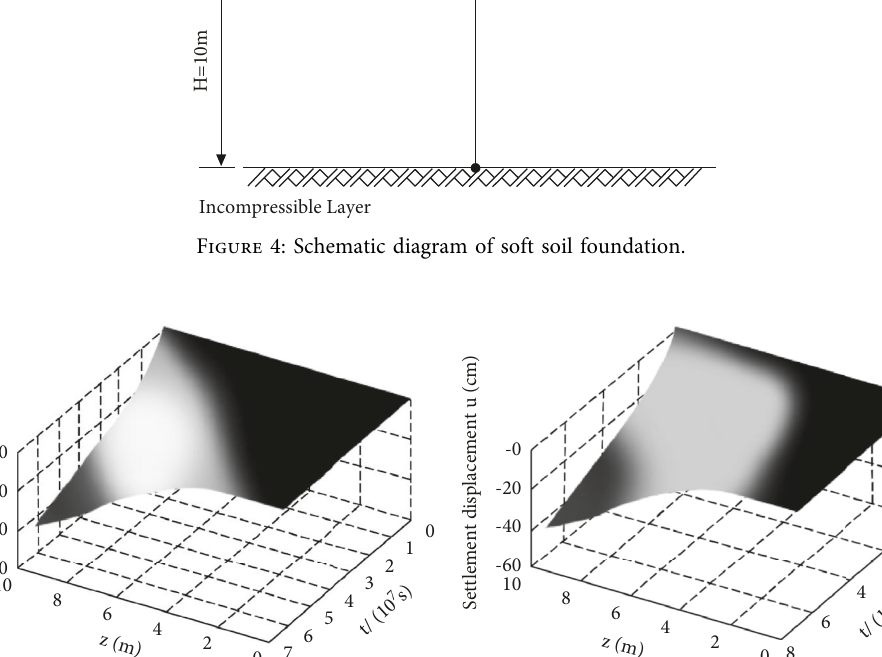
� 3.6 ∗ 10 − 7 cm/s. (b) k � 3.6 ∗ 10 − 6 cm/s. 0 0